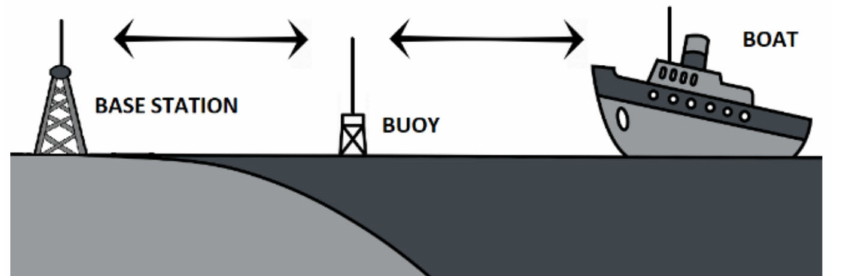
Figure 2. Second communication scenario in which a buoy performs the role of intermediary between the boat and the base